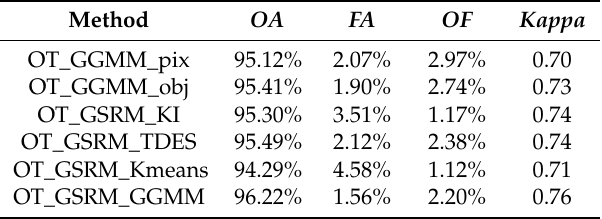
Table 6. Performance evaluation over LiangZi Lake between 2015 and 2016.